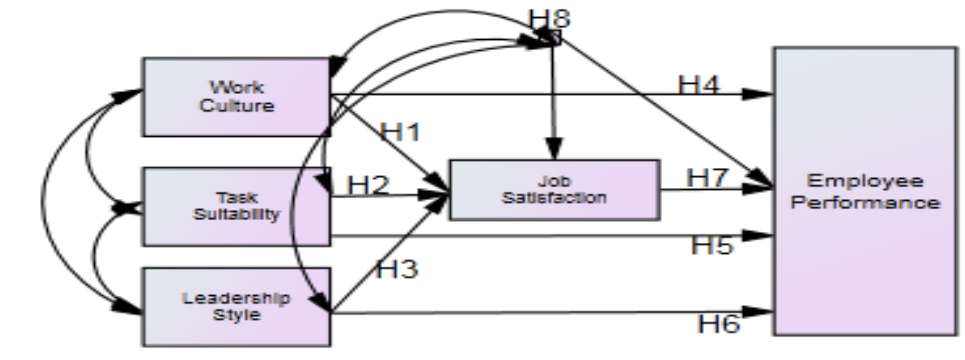
Figure 1 : Research Framework and